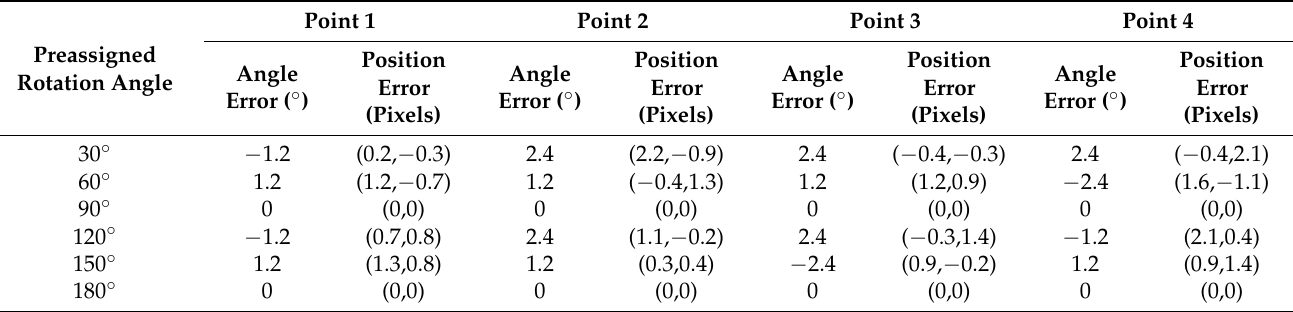
Table 1. Measurement results of the deformed images with different rotation angles.